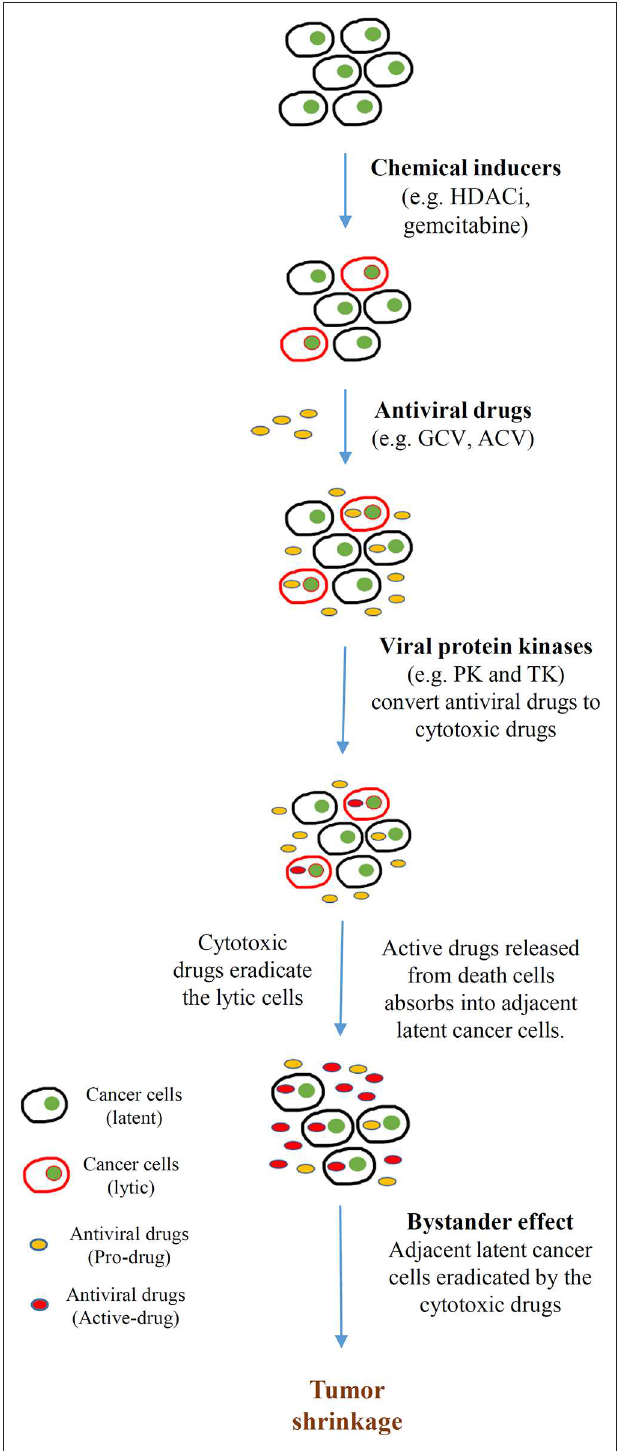
FIGURE 3 | Cytolytic therapy of Epstein-Barr virus (EBV)-associated cancers. Cancer cells harboring EBV in latent infection are induced to undergo reactivation by different chemical inducers [e.g., histone deacetylase inhibitors (HDACis), DNA-damaging agents (gemcitabine)]. Subsequently, the tumor is treated with antiviral drugs [e.g., ganciclovir (GCV), acyclovir (ACV)] that are